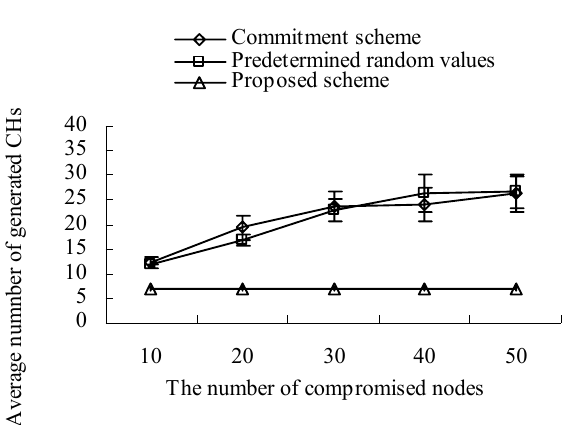
Figure 5. Generated CHs vs. compromised